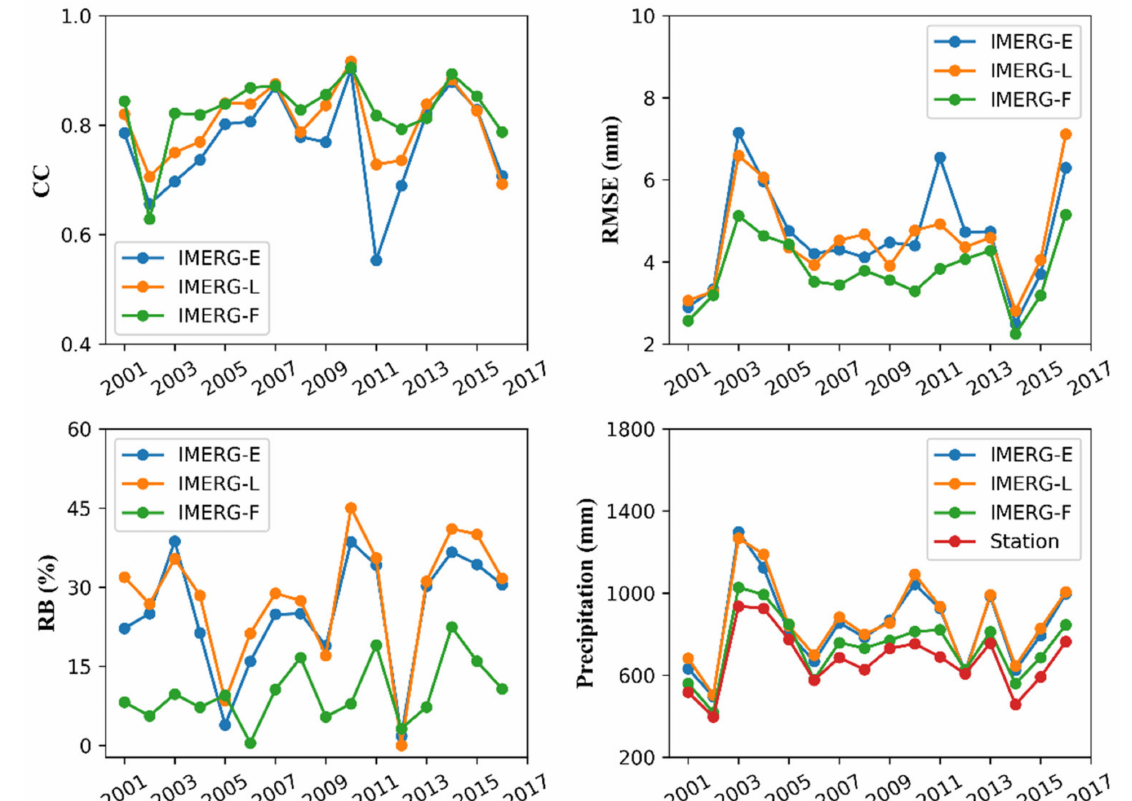
Figure 4. Annual continuous verification statistics for IMERG products, precipitation estimates from IMERG products, and land station precipitation measurements from 2001 to 2016 over Jinan